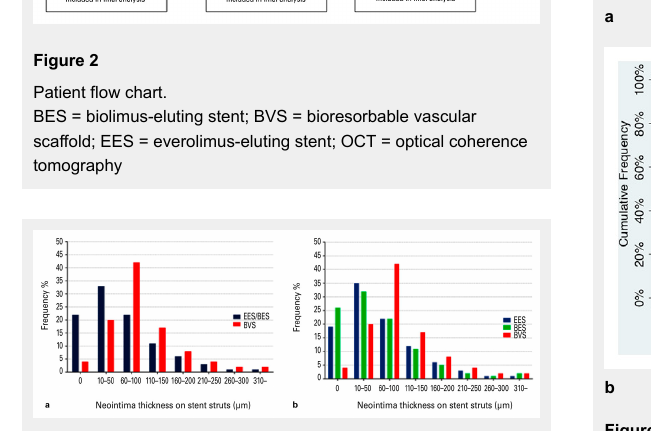
Figure 4a and b Cumulative frequency distribution of mean neointima volume at 9 months. The numbers provided are mean ± standard deviation. BES = biolimus-eluting stent; BVS = bioresorbable vascular scaffold; EES = everolimus-eluting